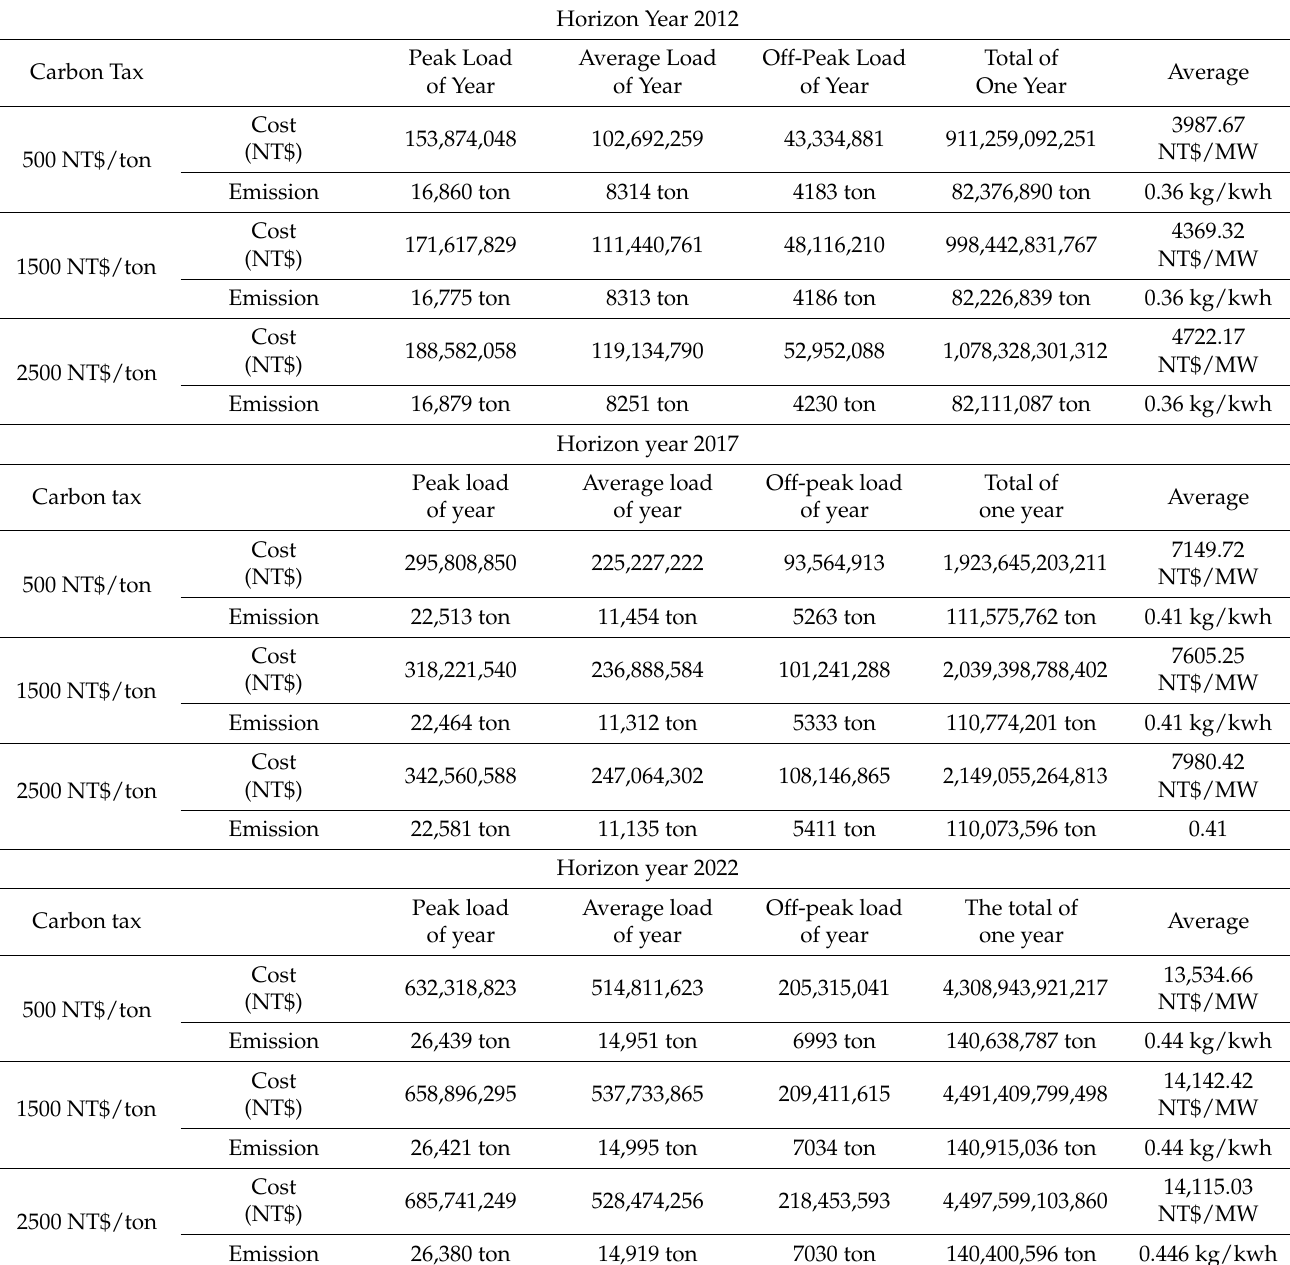
Table 5. The summary of the simulation results of Case